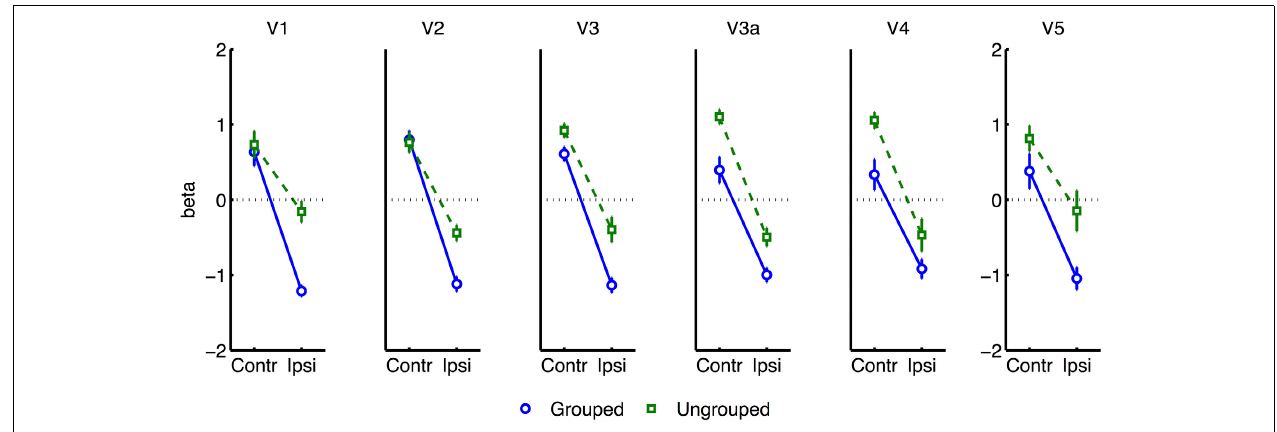
FIGURE 5 | Normalized block-related results for each area of visual